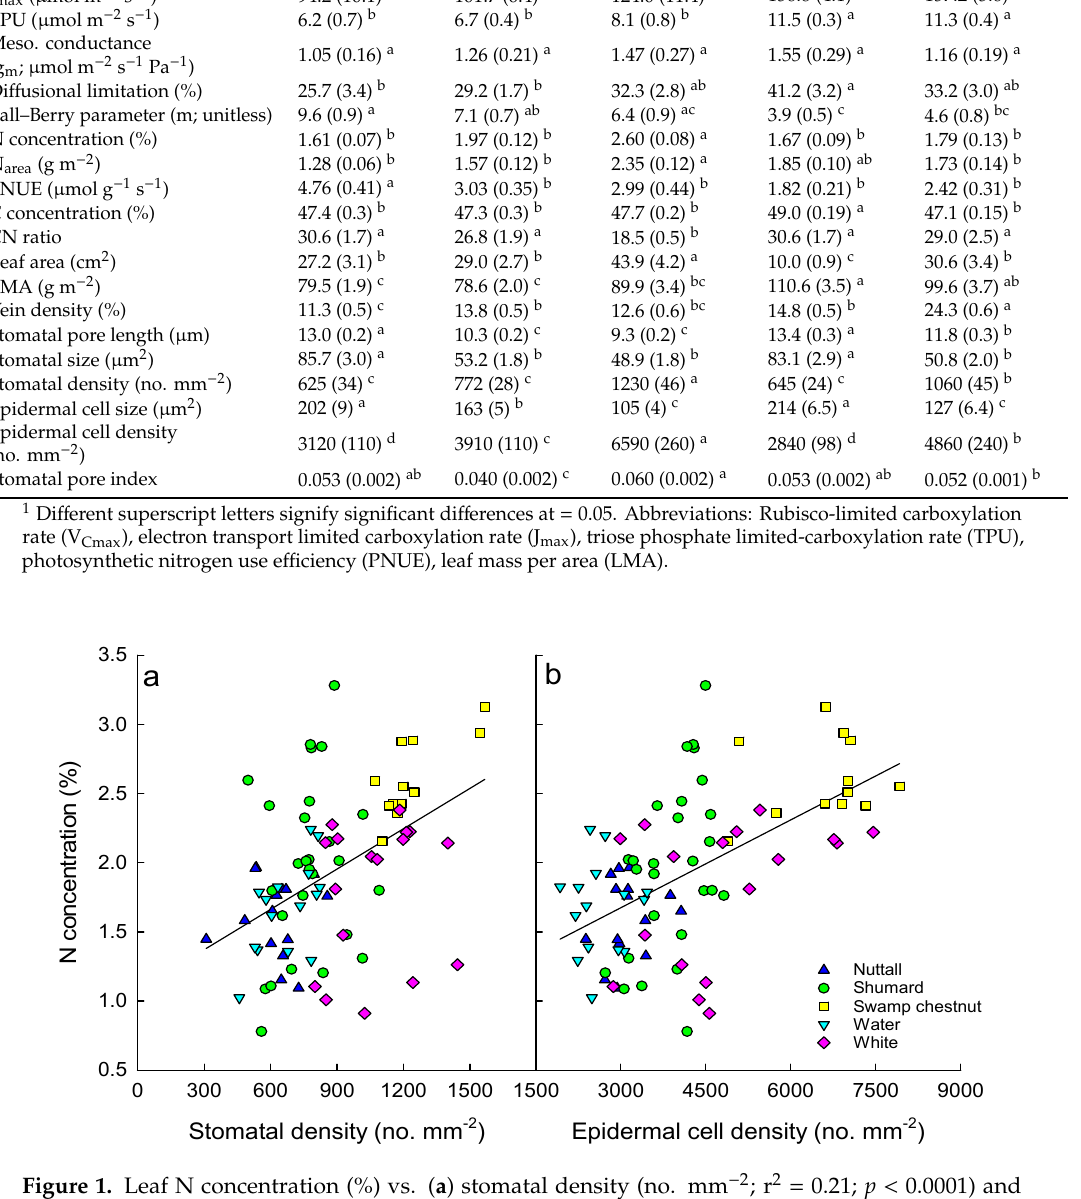
Figure 1. Leaf N concentration (%) vs. ( a ) stomatal density (no. mm − 2 ; r 2 = 0.21; p < 0.0001) and ( b ) epidermal cell density (no. mm − 2 ; r 2 = 0.31; p < 0.0001) for Nuttall (dark blue, up triangle), Shumard (green circle), swamp chestnut (yellow square), water (light blue down triangle), and white oak (magenta diamond).